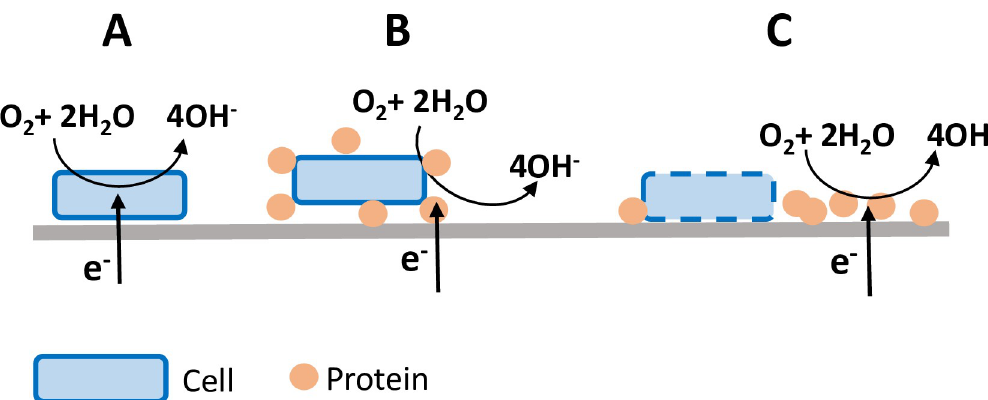
Fig 10. Three speculated electron transfer pathways. A) Catalysis by cellular metabolism via direct electron transfer from the electrode to the cell, B) catalysis due to membrane-bound proteins, C) catalysis by proteins released onto the electrode